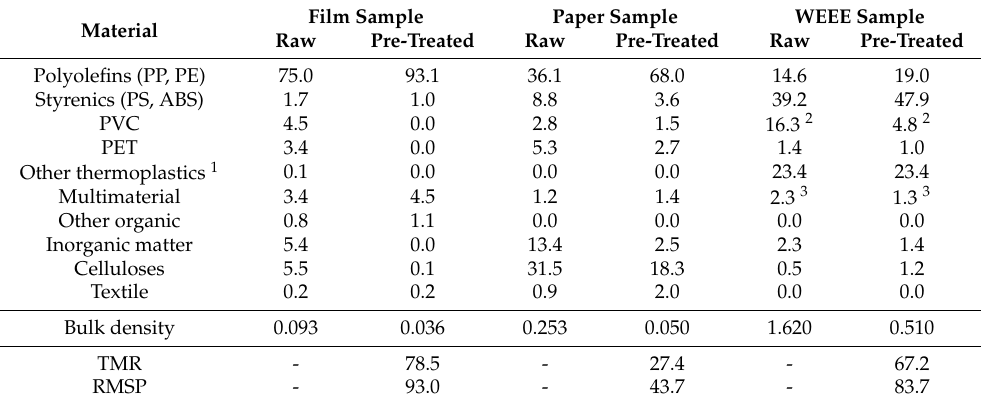
Table 2. Material composition (wt.%) and bulk density (kg m − 3 ) of raw and pre-treated samples. Film Sample Paper Sample WEEE Sample Material Raw Pre-Treated Raw Pre-Treated Raw Pre-Treated Polyolefins (PP,